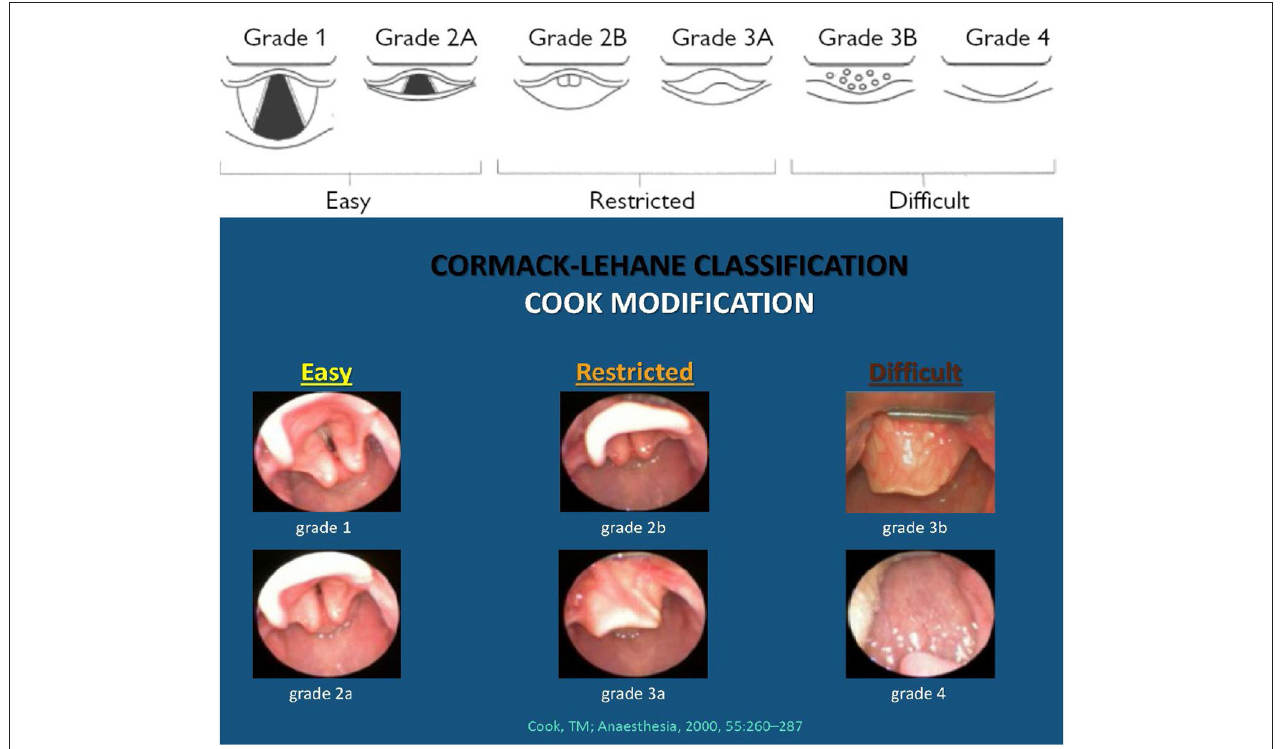
FIGURE 1 | The modified Cook’s practical classification of laryngeal view. “The view is easy (E) when the laryngeal inlet is visible. These views are suitable for intubation under direct vision. The view is restricted (R) when the posterior glottic structures (posterior commissure or arytenoid cartilages) are visible or the epiglottis is visible and can be lifted. These views are likely to benefit from indirect methods (e.g., gum elastic bougie). A difficult (D) view is present when the epiglottis cannot be lifted or when no laryngeal structures are visible. These views are likely to need advanced methods for intubation.” The figure and text are reproduced from “ A new practical classification of laryngeal view; Anesthesia, 2000, 55, 260–287 ” with permission from Prof. T. M. Cook, MD, 21.01.2021, and RightsLink/John Wiley and Sons. The photographic part (with the blue background) minus photo “Grade 3b” (Grade 3b: Reprinted with permission from openairway.org.) along with other minor changes by author G. Berisha, MD, has been reproduced with permission from Carin A. Hagberg, MD, FASA,